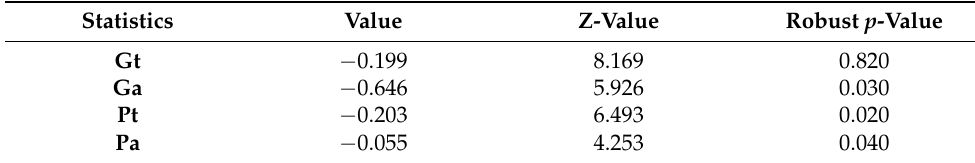
Table 10: Table 10. Westerlund ECM panel cointegration